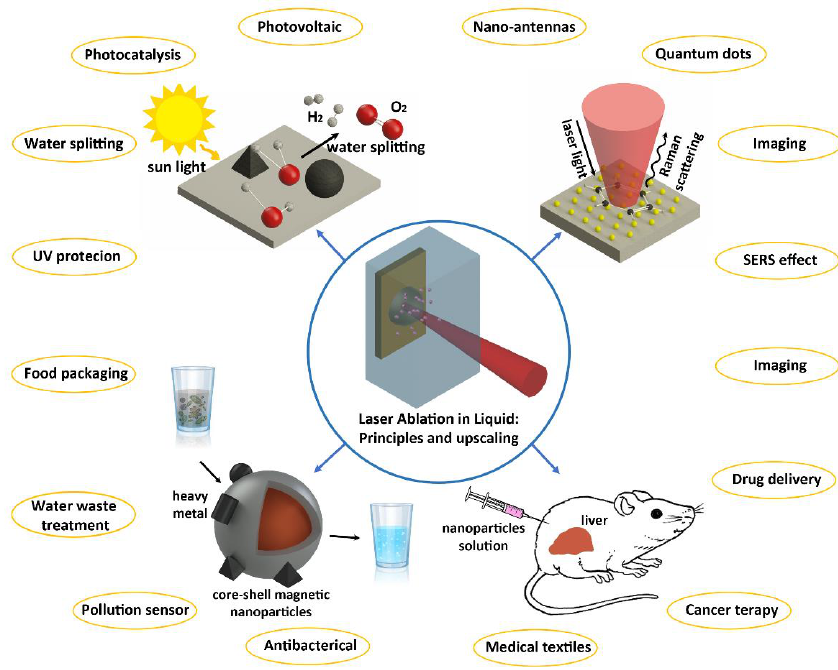
Figure 1. Schematic showing the outline of the review. From the fundamentals and up-scaling, in the center, arrows point outwards to the four application areas.